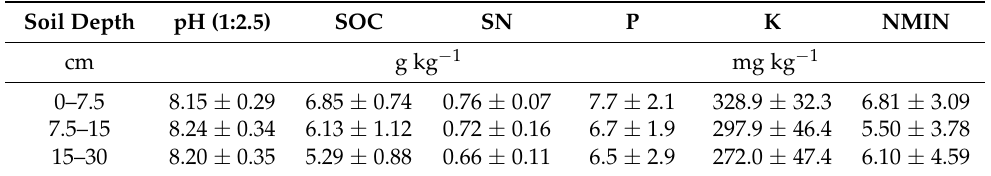
Table 1. Initial soil main nutrient content in 2008, mean values ± std dev ( n = 12). Soil Organic Carbon (SOC), Soil Nitrogen (SN), Olsen available Phosphorus (P), available Potassium (K) and Mineral Nitrogen content (NMIN = NH 4 -N + NO 3